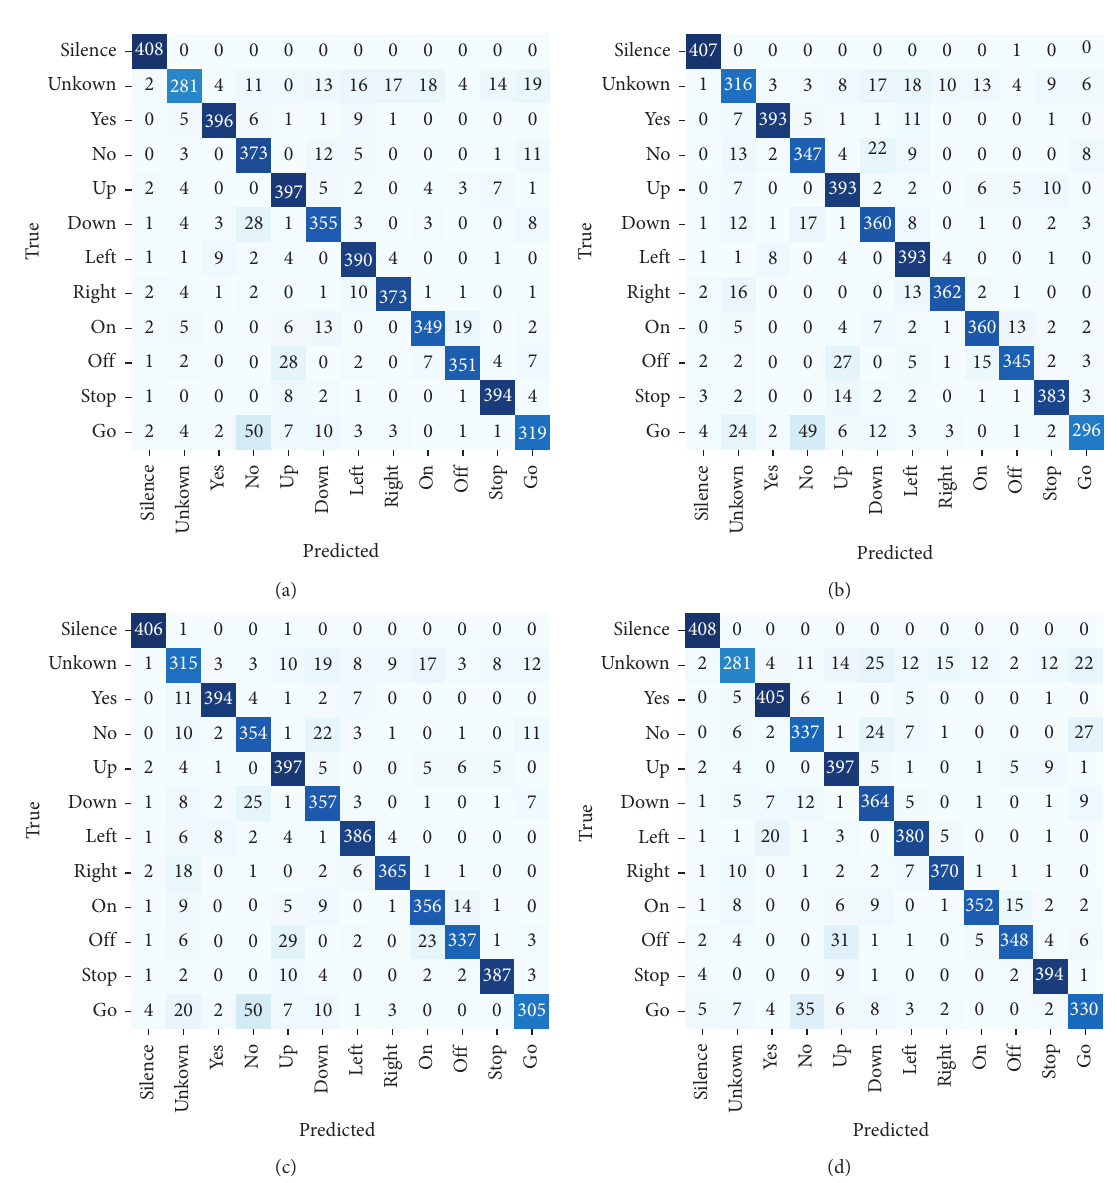
Figure 8: Confusion matrices: (a) the applied method (50, 50); (b) the applied method (150, 100); (c) the applied method (180, 300); (d) the gradient descent